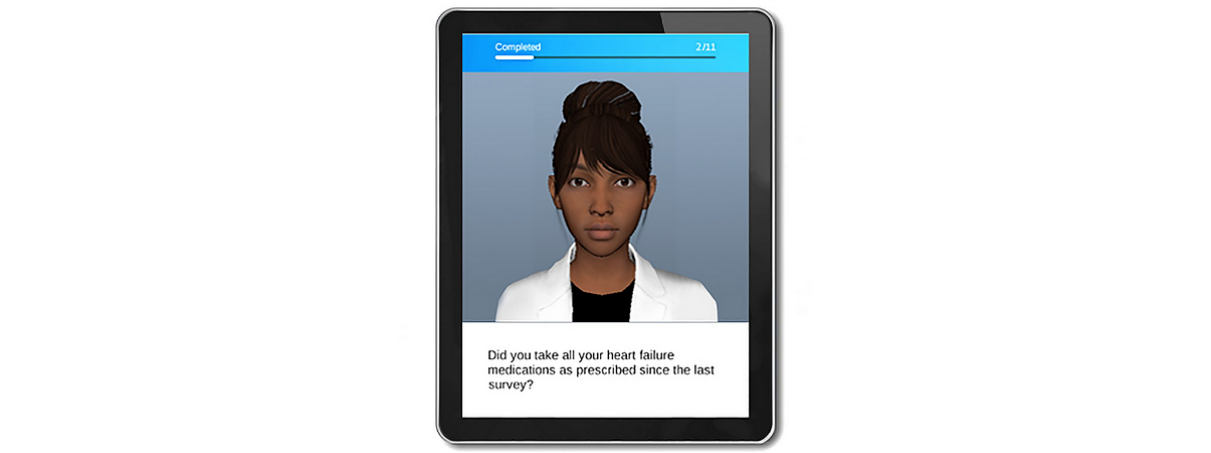
Figure 1. Avatar on a